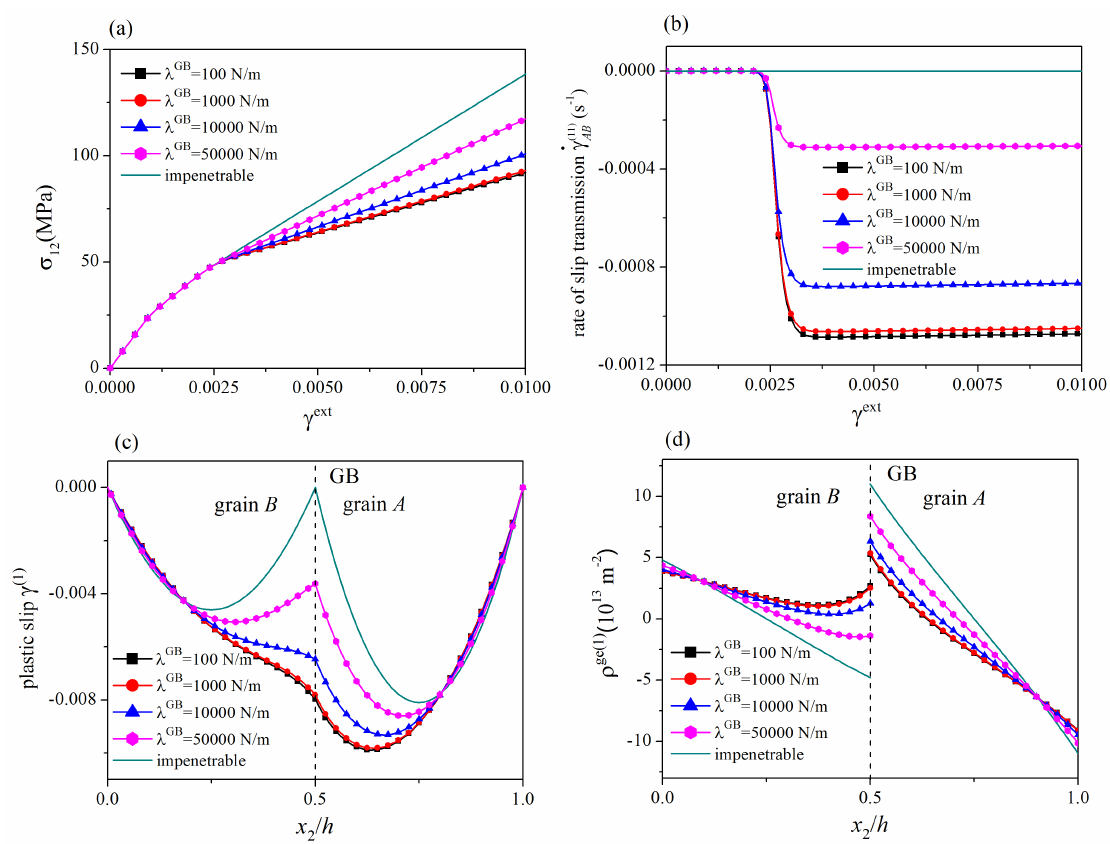
Figure 3. Influence of energetic GB hardening modulus: ( a ) stress-strain curves; ( b ) the rate of slip transmission; ( c ) distribution of plastic slip at γ ext = 0.01; ( d ) distribution of GND density at γ ext = 0.01. The critical load for the onset of slip transmission depends on the initial GB resistance R GB . For decreasing energetic GB hardening modulus λ GB , the steady-state value of the rate of slip 0 transmission increases, the strain hardening rate after the onset of slip transmission decreases, and the curve of distribution of plastic slip becomes smoother at the